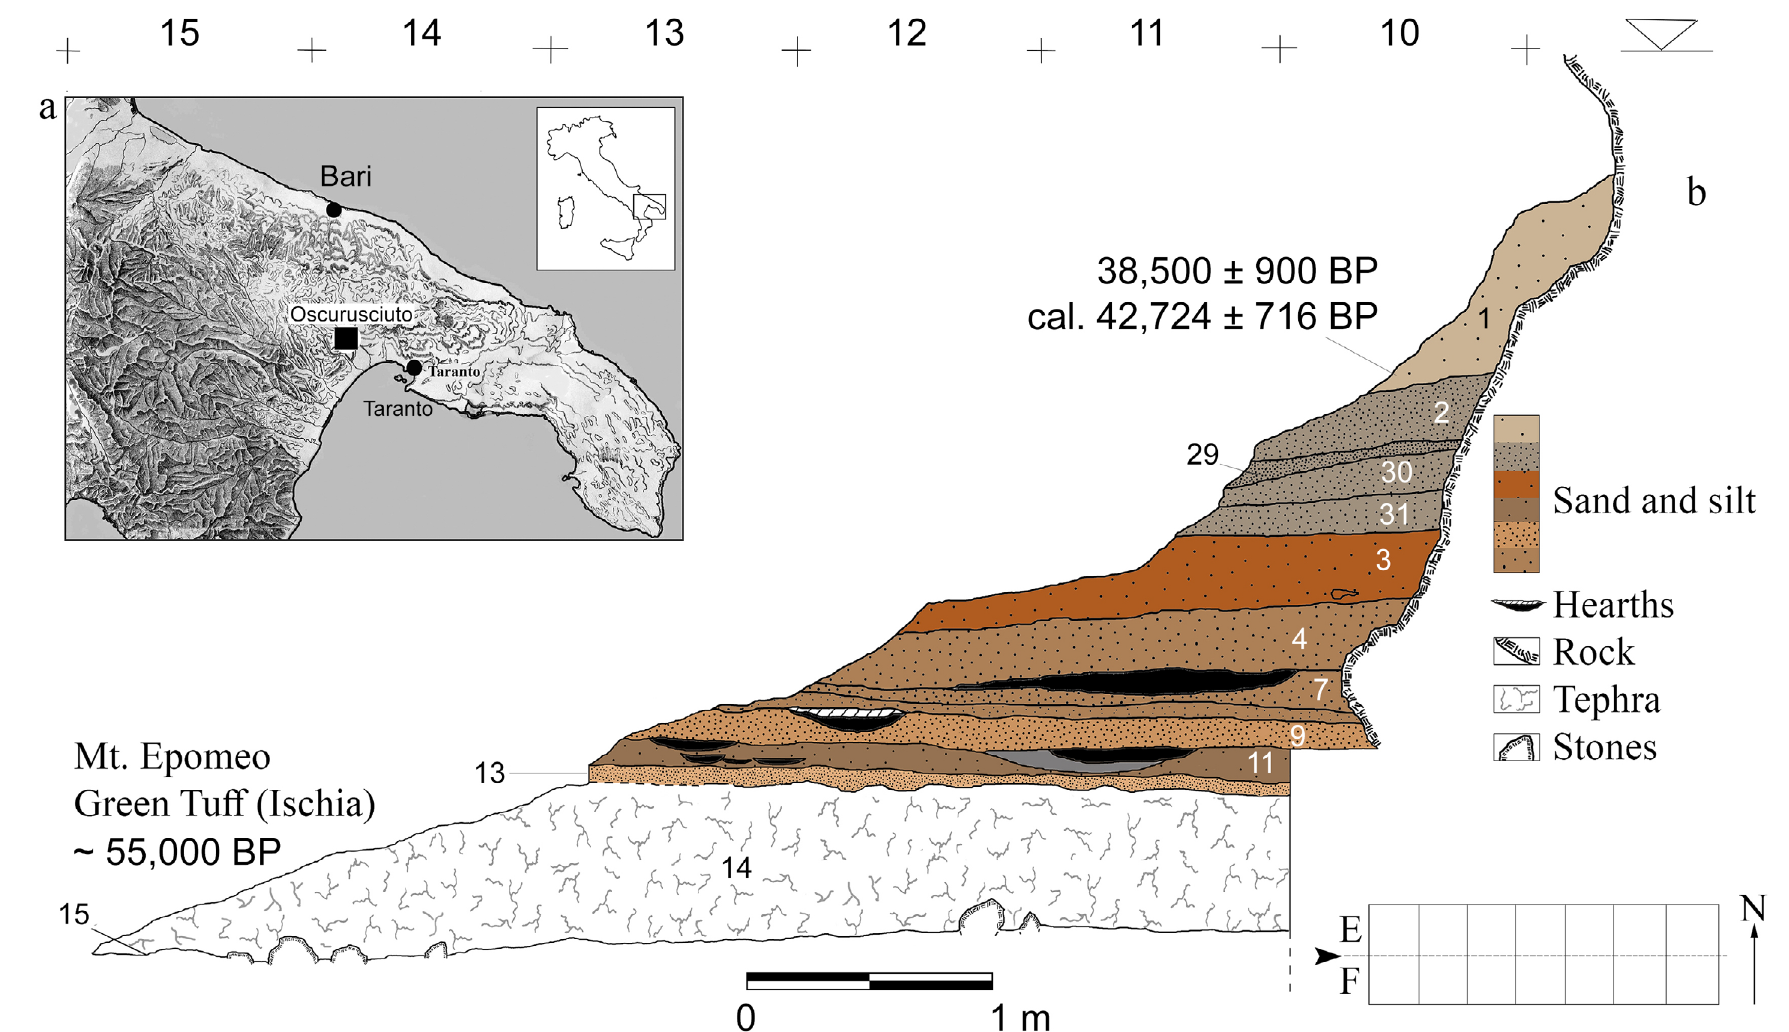
Figure 2. Localization (a) and stratigraphic sequence (so far excavated) of the Oscurusciuto rock shelter (b). (Relief map by P. Boscato; drawing by A.